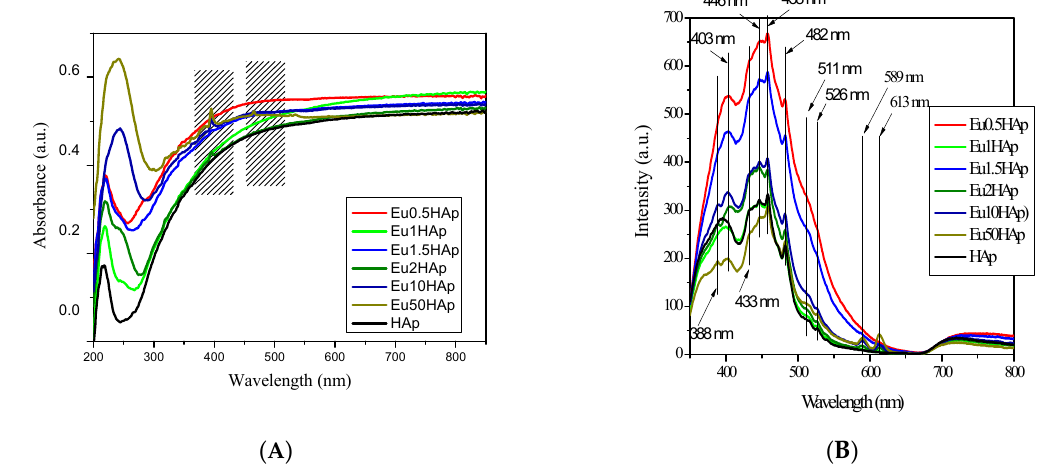
Figure 8. ( A ) UV-Vis absorption spectra of Eu X HAp at different Eu-concentrations ( B ) Room-temperature photoluminescence spectra of Eu X HAp at different Eu-concentrations.